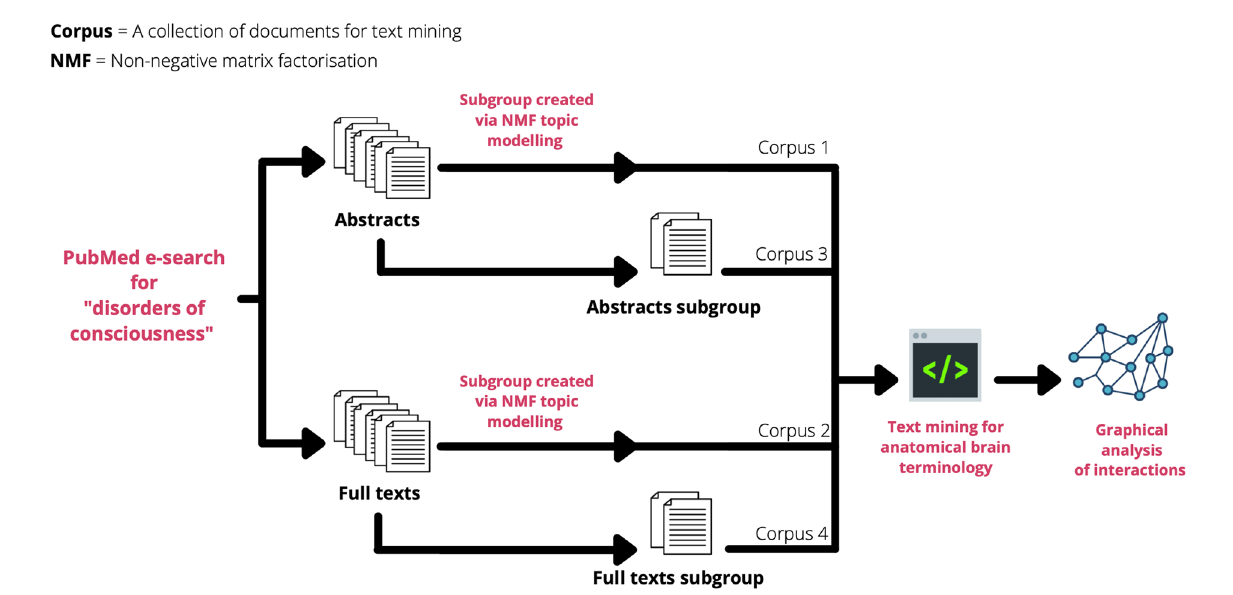
FIGURE 1 Flowchart of how each corpus was prepared from the original PubMed search